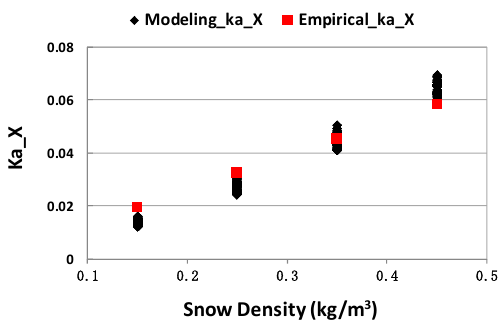
Figure 7. Comparison between the empirically estimated absorption coefficient through Equation (16) and the one simulated by the bi-continuous-VRT model.